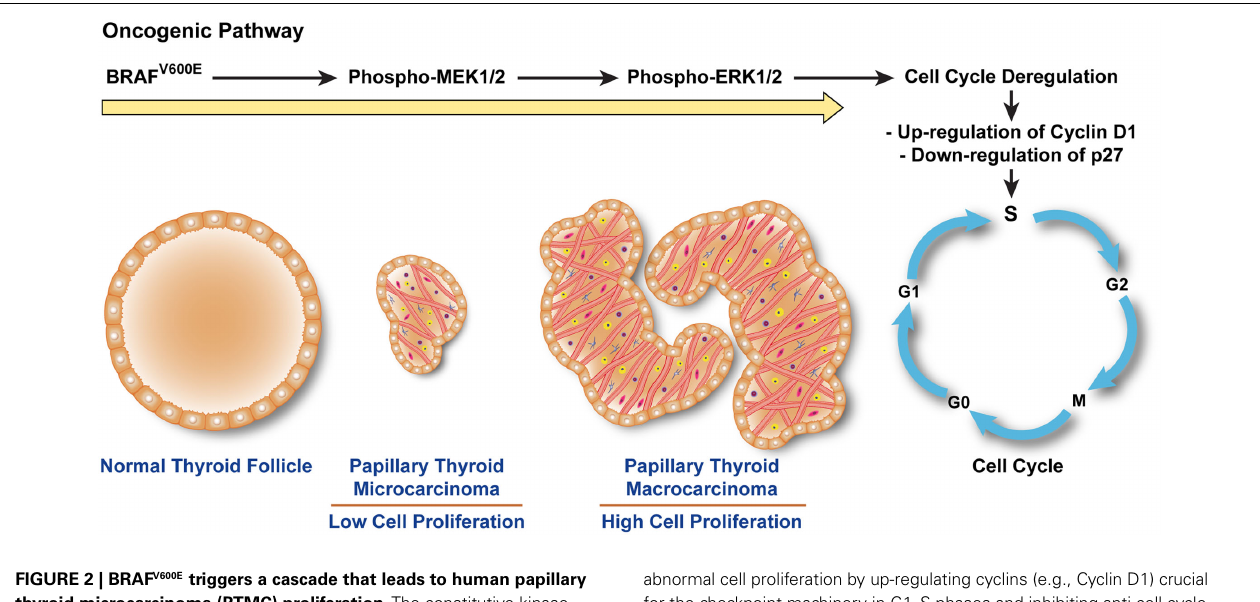
FIGURE 2 | BRAF V600E triggers a cascade that leads to human papillary thyroid microcarcinoma (PTMC) proliferation. The constitutive kinase activity of BRAF V600E phosphorylates and activates MEK1/2. Phospho-MEK1/2 induces hyperphosphorylation of ERK1/2 which translocates into the nucleus, triggering cell cycle progression, and